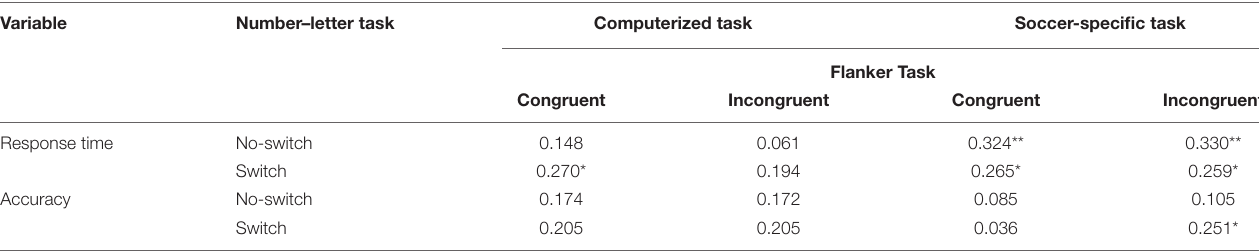
TABLE 2 | Correlations between inhibition (measured with congruent and incongruent trials in the flanker task) and cognitive flexibility (measured with switch and no-switch trials in the number–letter task) in the general, computerized and the soccer-specific tasks.